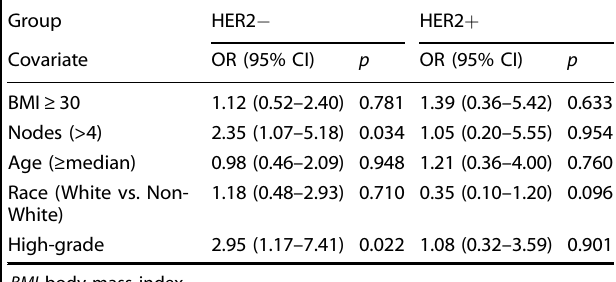
Table 4. Associations of covariates with relapsed breast cancer, by HER2